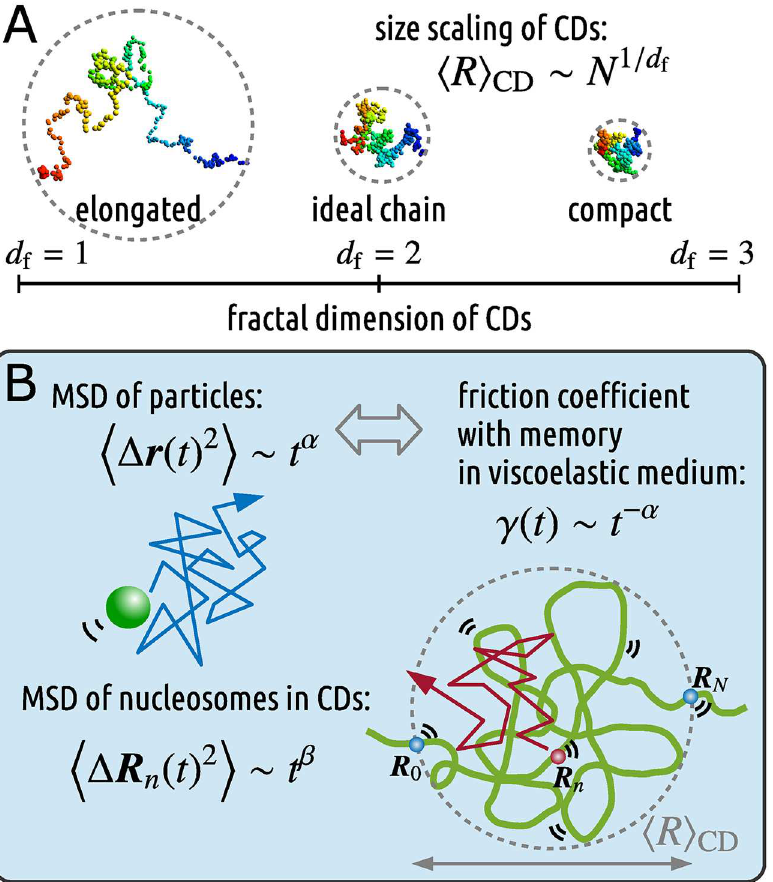
Fig 1. Schematic illustration of our polymer model for CDs. (A) A nucleosome fiber is represented as a polymer bead chain and forms a CD. The size scaling of CDs is expressedas h R i dimensionrepresents the effective conformational state of CDs: d f = 1, 2, and 3 correspondto a straight line, the ideal chain, and the fractal globule, respectively. (B) The viscoelasticity of the medium, where the movement of particles shows the subdiffusive FBM h Δ r ( t ) 2 i * t α , is describedusing the friction coefficient with memory, γ ( t ) * t − α . When a nucleosome with coordinates R n ( t ) dynamically fluctuates in the viscoelastic medium, the movement of nucleosomes in CDs shows subdiffusion: h Δ R n ( t ) 2 i * t β